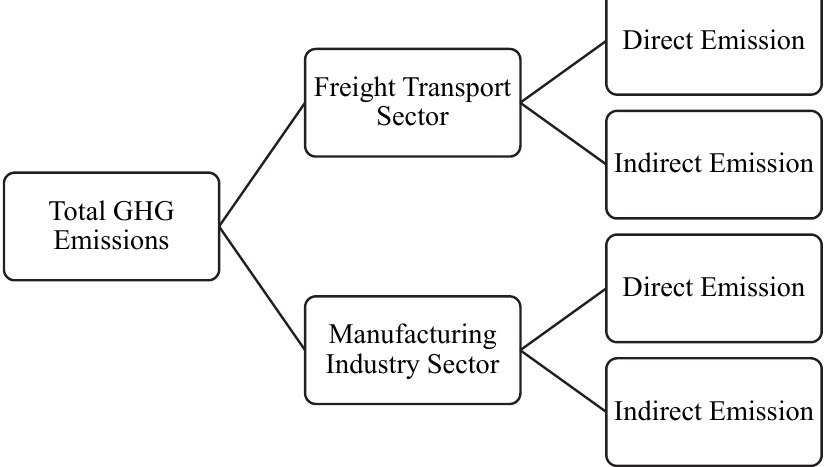
Fig. 1. The classification of emissions in this